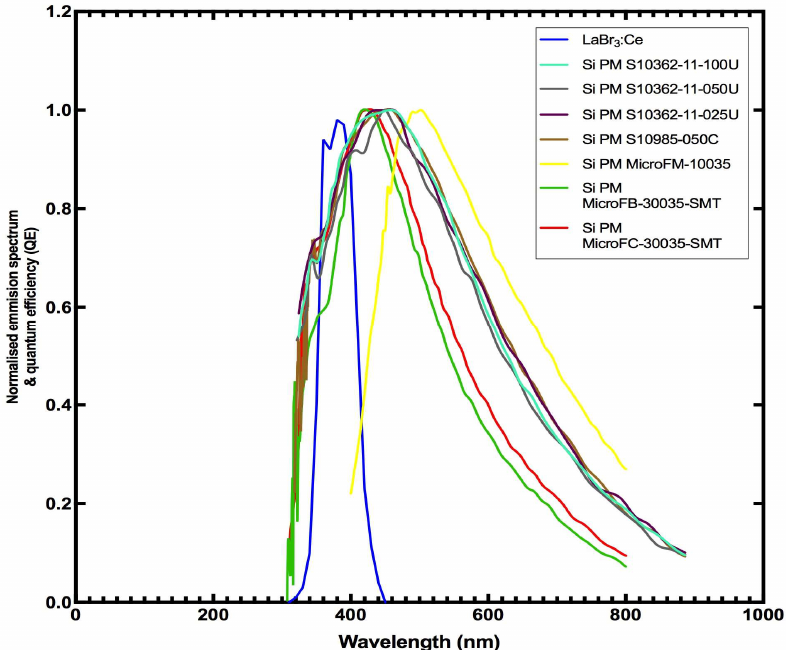
Figure 10. Optical spectra distribution of LaBr 3 :Ce, and spectral sensitivity of SiPMs.